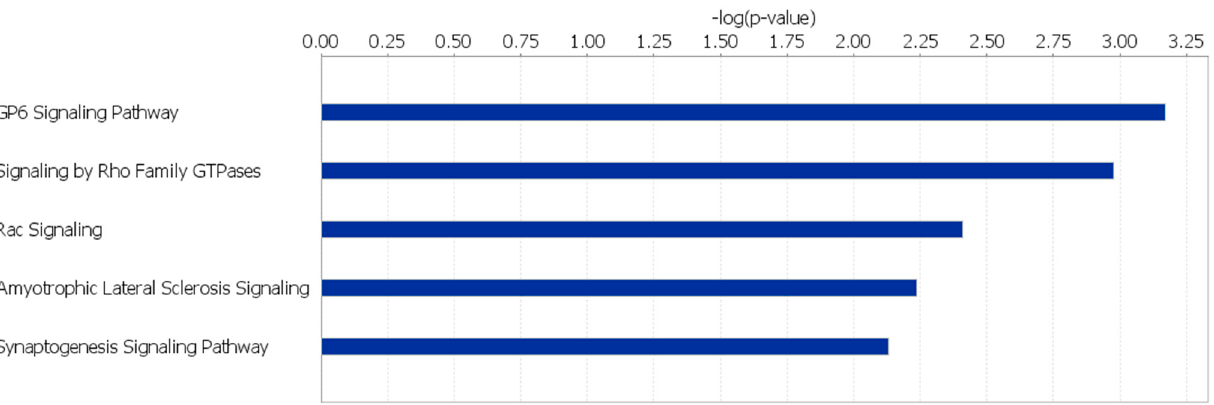
Figure 2. Canonical pathways affected by unique SNPs in LS lines of Japanese quail.